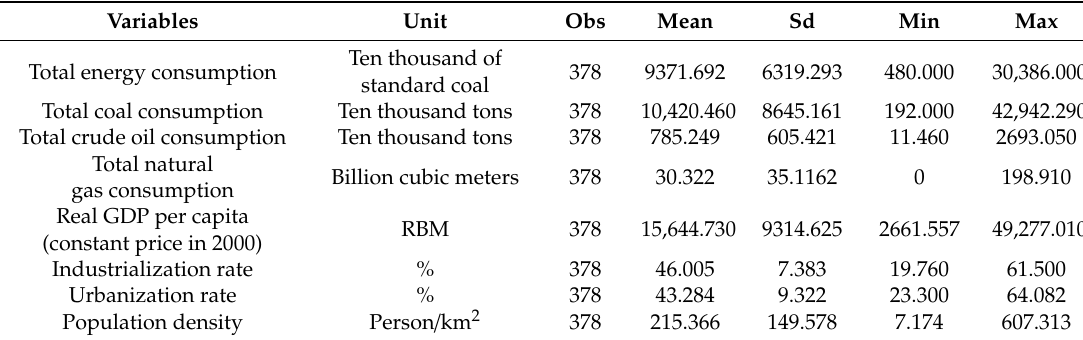
Table 2. Descriptive statistical results of